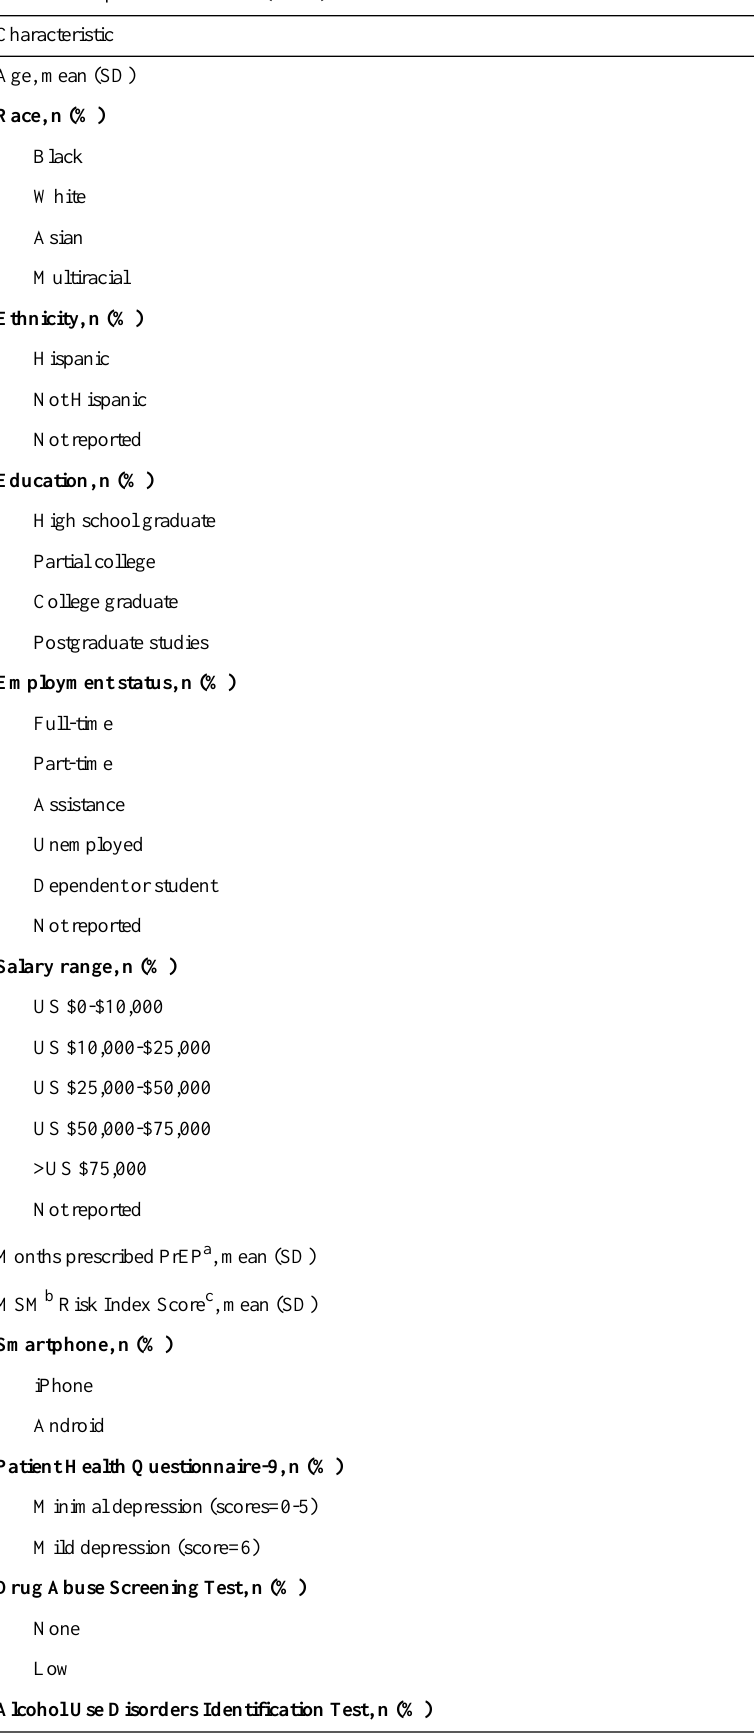
Table 2. Sample characteristics